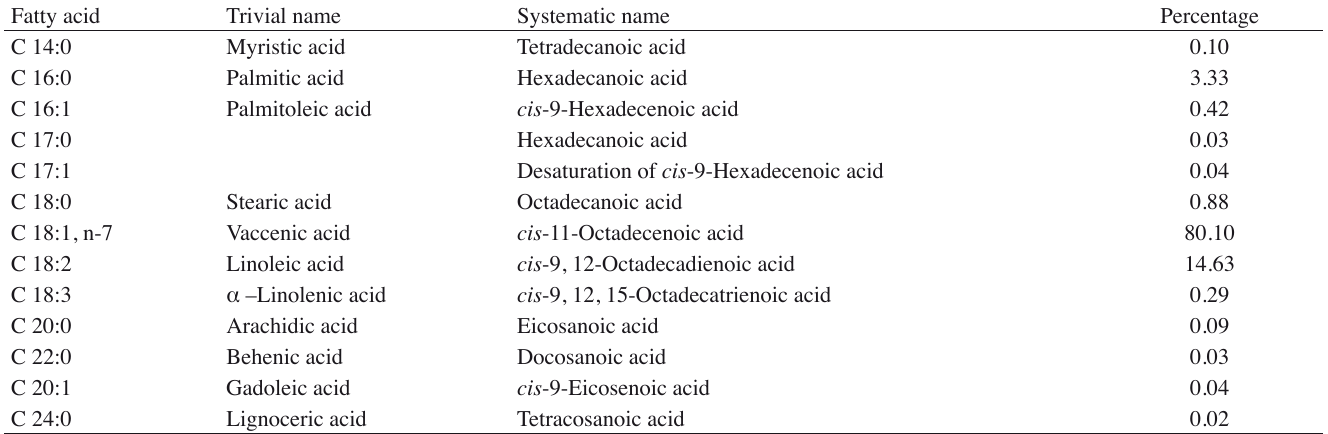
Table 4 - Fatty acid content in seed of C.